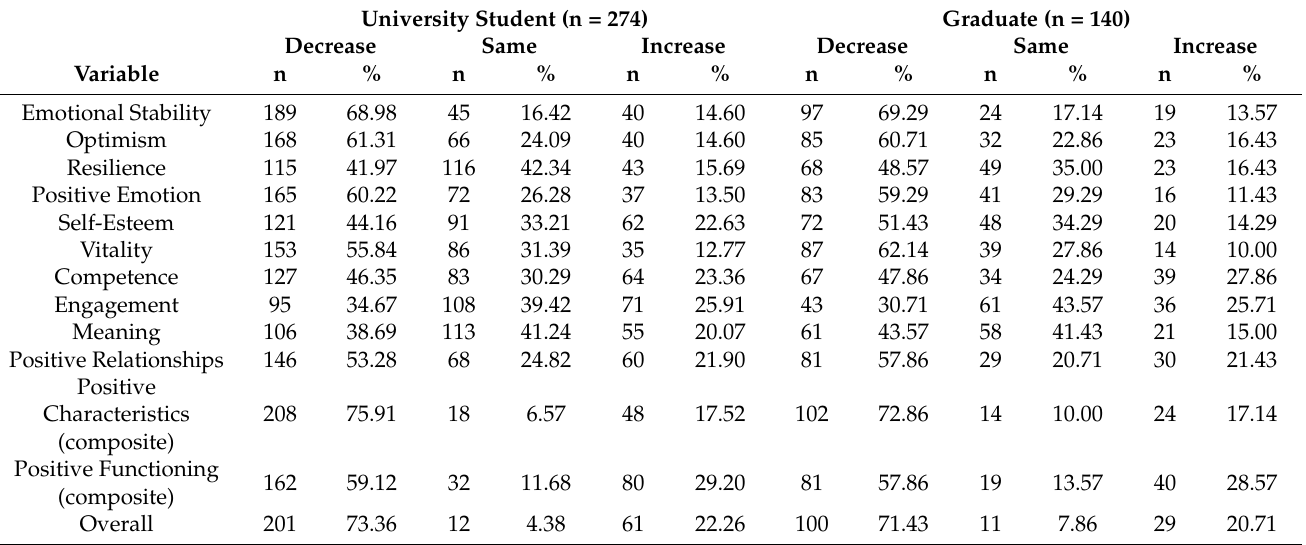
Table 5. Proportions of score changes before and since COVID-19 at item and scale level (n = 414).